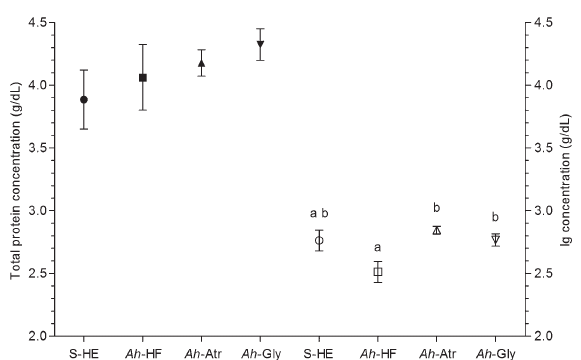
Figure 3. Total serum proteins (closed symbols) and immuno- globulins (open symbols) from silver catfish fingerlings (for details, see Figure 2). Data are reported as means±SE. One- way ANOVA and the Bonferroni post-test were used to compare the data and significant differences (P , 0.05) are indicated by different